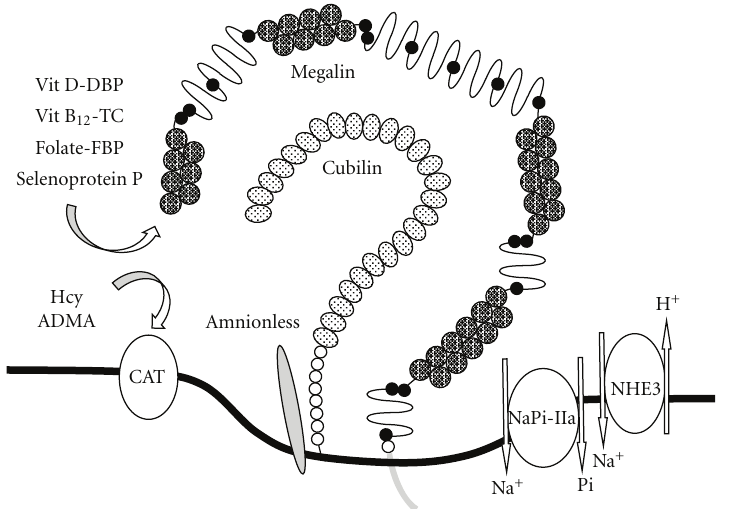
Figure 2: Endocytic receptors and transporters involved in the uptake of substances at the apical membranes of proximal tubule cells (PTCs). At apical membranes of PTCs, megalin and the cubilin-amnionless complex are involved in endcytosis of protein ligands. Megalin facilitates uptake of various ligands including vitamin D/vitamin D-binding protein (DBP), vitamin B 12 /transcobalamin (TC), folate/folate- binding protein (FBP) complexes, and selenoprotein P. Similarly, cubilin facilitates uptake of the vitamin D/DBP complex. Type IIa Na/Pi cotransporter (NaPi-IIa) and Na + /H + exchanger isoform 3 (NHE3) are primarily involved in the uptake of phosphate and sodium, respectively. Homocysteine (Hcy) and asymmetric dimethylarginine (ADMA) may be taken up by cationic amino acid transporters (CATs) and metabolized in PTCs. Dysregulation of the uptake or metabolism of these substances in PTCs in patients with CKD, especially with diabetic nephropathy, is likely to be involved in the mechanism that promotes the development of